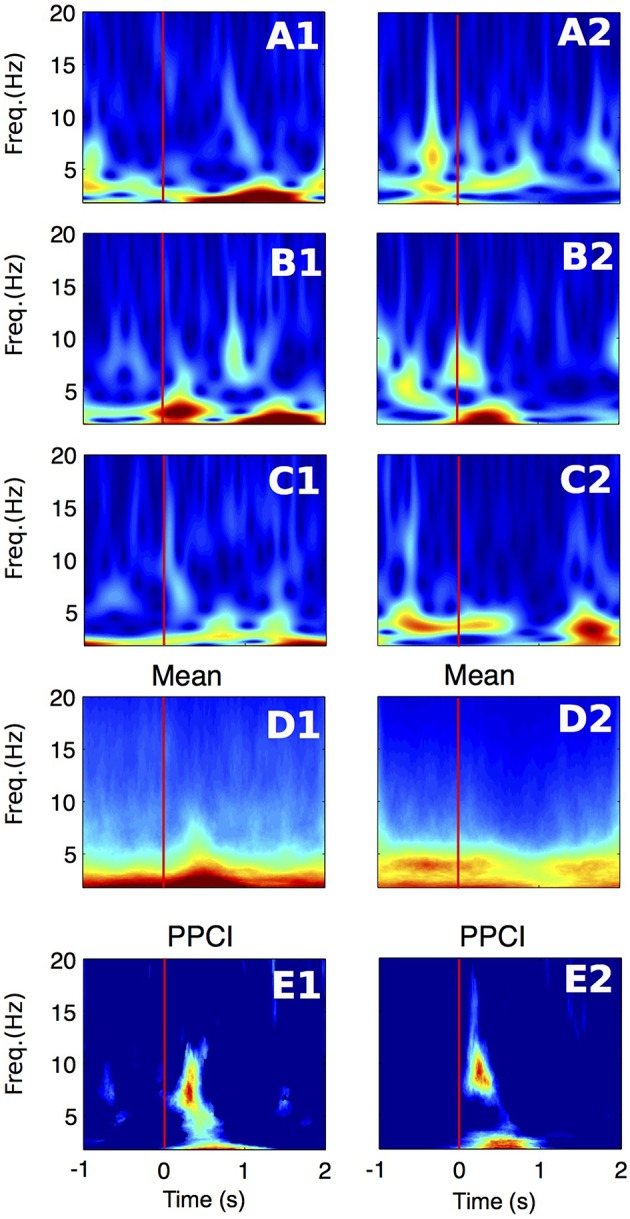
Time-frequency representations of the EEG signal recorded in the right hippocampal electrode of two patients (1–2). (A–C) Wavelet spectrogram of three successive trials in two patients (1–2). Color scale (from blue to dark red) for panels (A1–D1): 0–70 μV2/Hz, for panels (A2–D2): 0–30 μV2/Hz (D) Average power for the whole session in the same electrodes. Color scale same as in panels (A–C). (E) Time-frequency representation of PPCI in all bands. Here, phase was extracted directly from the wavelet coefficients computed in all trials. Color scale (from blue to dark red) for panel (E1): 0–0.09, for panel (E2): 0–0.14.